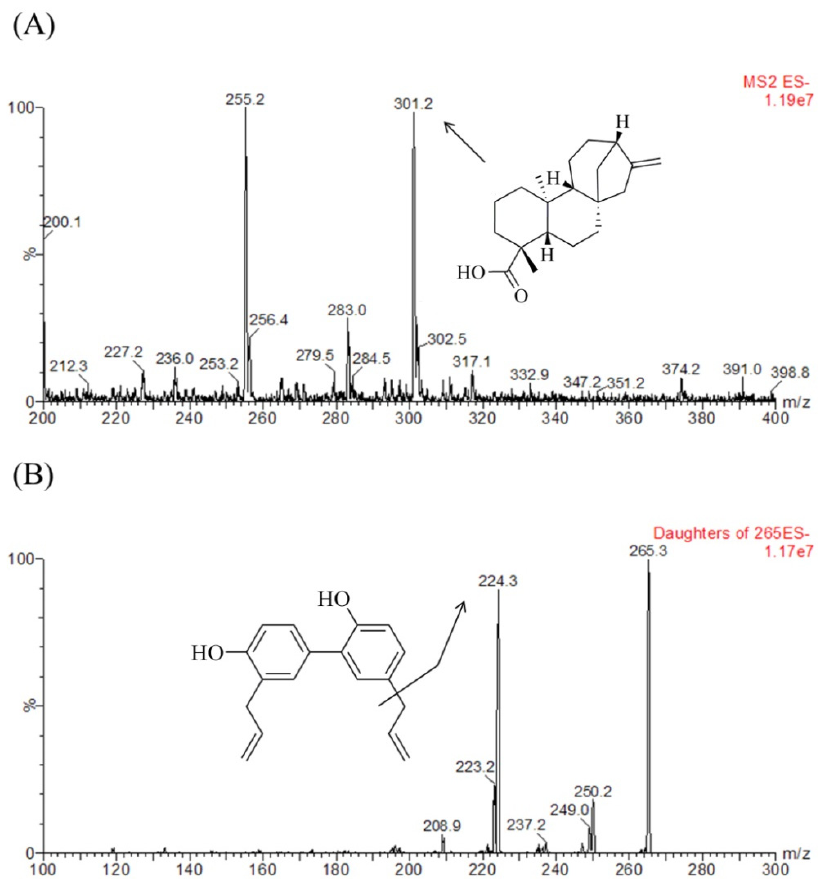
Figure 2. Negative ion electrospray mass scan spectra of ( A ) KAU and ( B ) honokiol (IS).